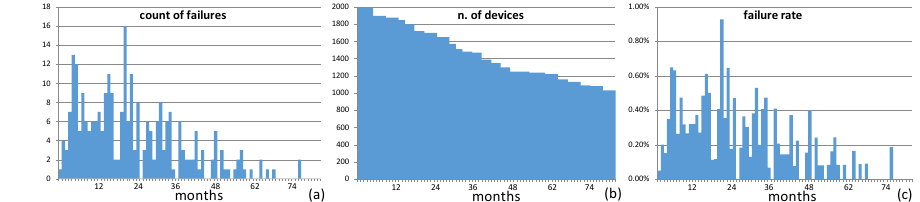
Figure 4. Number of failures per each month over time ( a ), sample size over time ( b ) and failure rate over time ( c ).